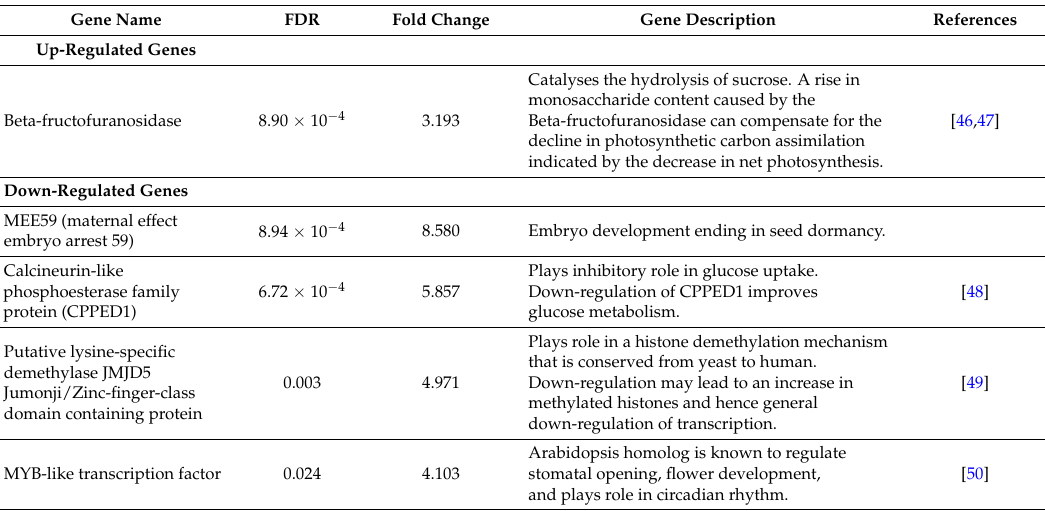
Table 5. Overlapping up- and downregulated genes.